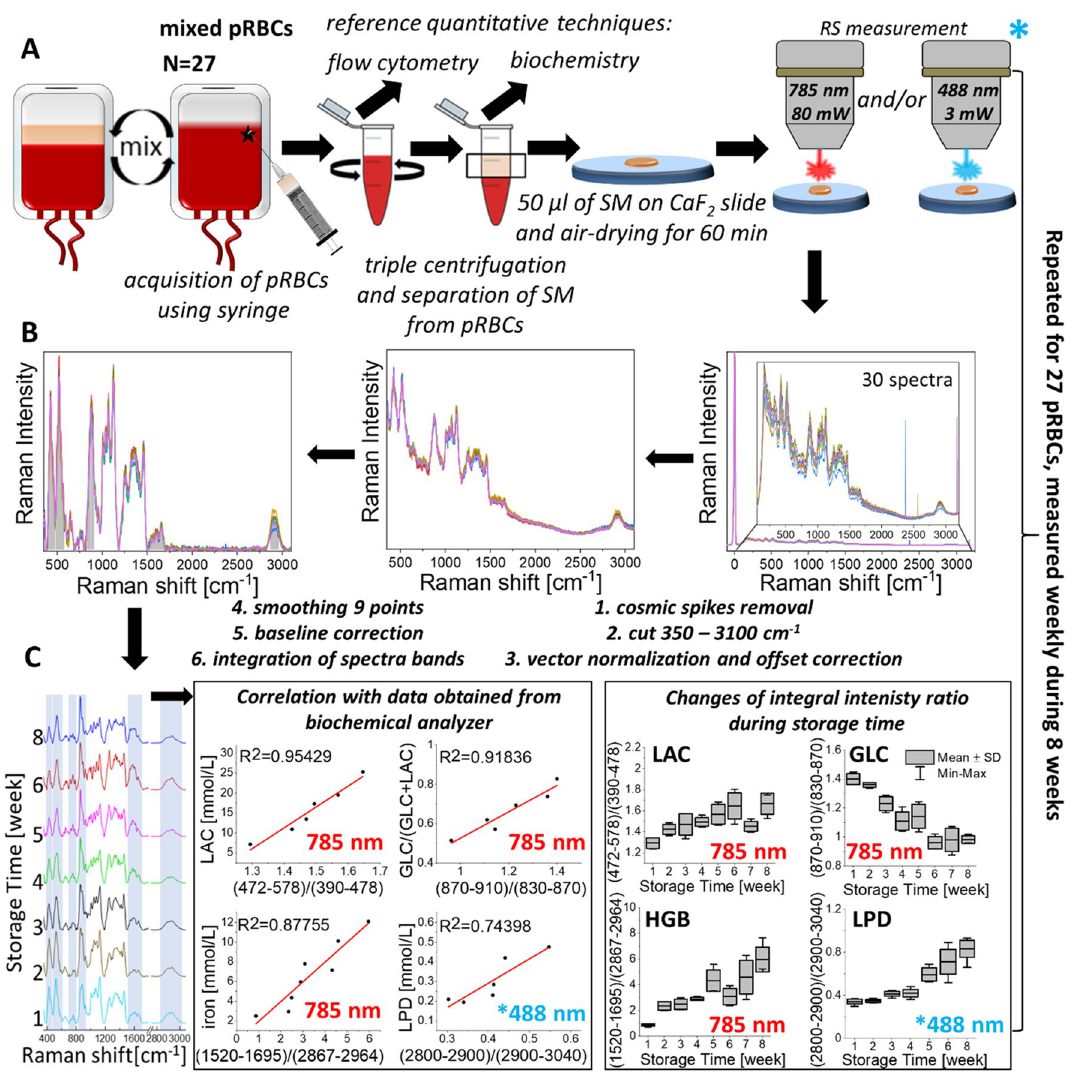
Figure 1. Schematic overview of the designed strategy. ( A ) pRBCs samples preparation and RS measurement intended for weekly SM analysis during period of 8 weeks in correlation to reference quantitative analysis to define the most sensitive and reliable RS spectral marker bands of pRBCs quality determination. The pRBC bags were mixed, subsequently, samples were aspirated using syringe directly through the PVC storage bag and then centrifuged in plastic tubes. Separated as upper fraction SM was aspirated and divided into two—first used for reference quantitative analysis and second for RS measurements. In the latter, 50 μ of SM was